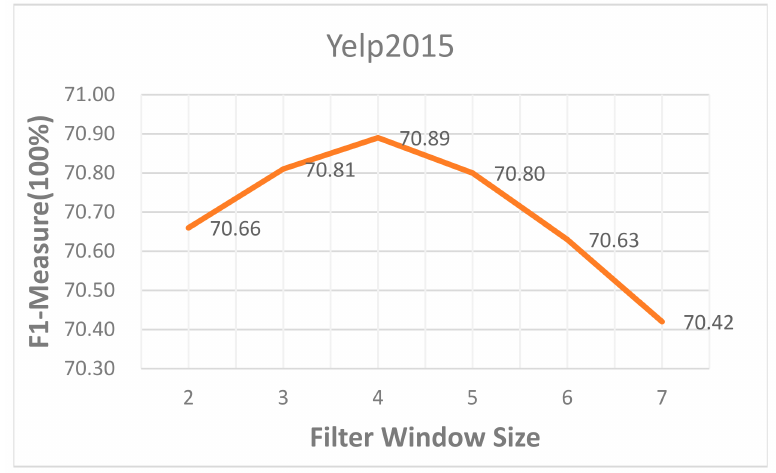
Figure 4. Effect of filter window